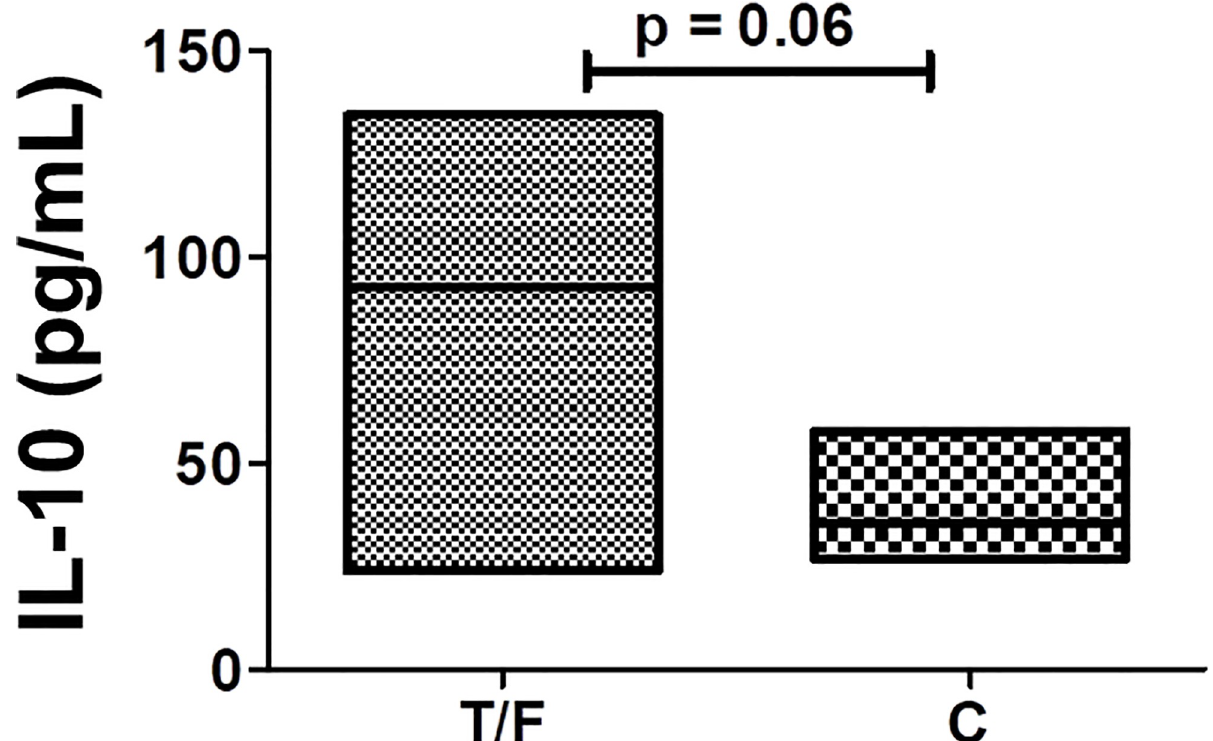
Fig 4. Association between MDDC IL-10 secretion and HIV-1 Transmission. Envelopes (Envs) were grouped on whether they were sampled 2–5 weeks post-infection (wpi) or 2–3 years post-infection (ypi). Pseudovirus was used to stimulate up to seven MDDC donors and median IL-10 levels were compared between matched acute and chronic infection pairs using a Wilcoxon signed rank paired test. Data represents all nine clones used in Fig 2.